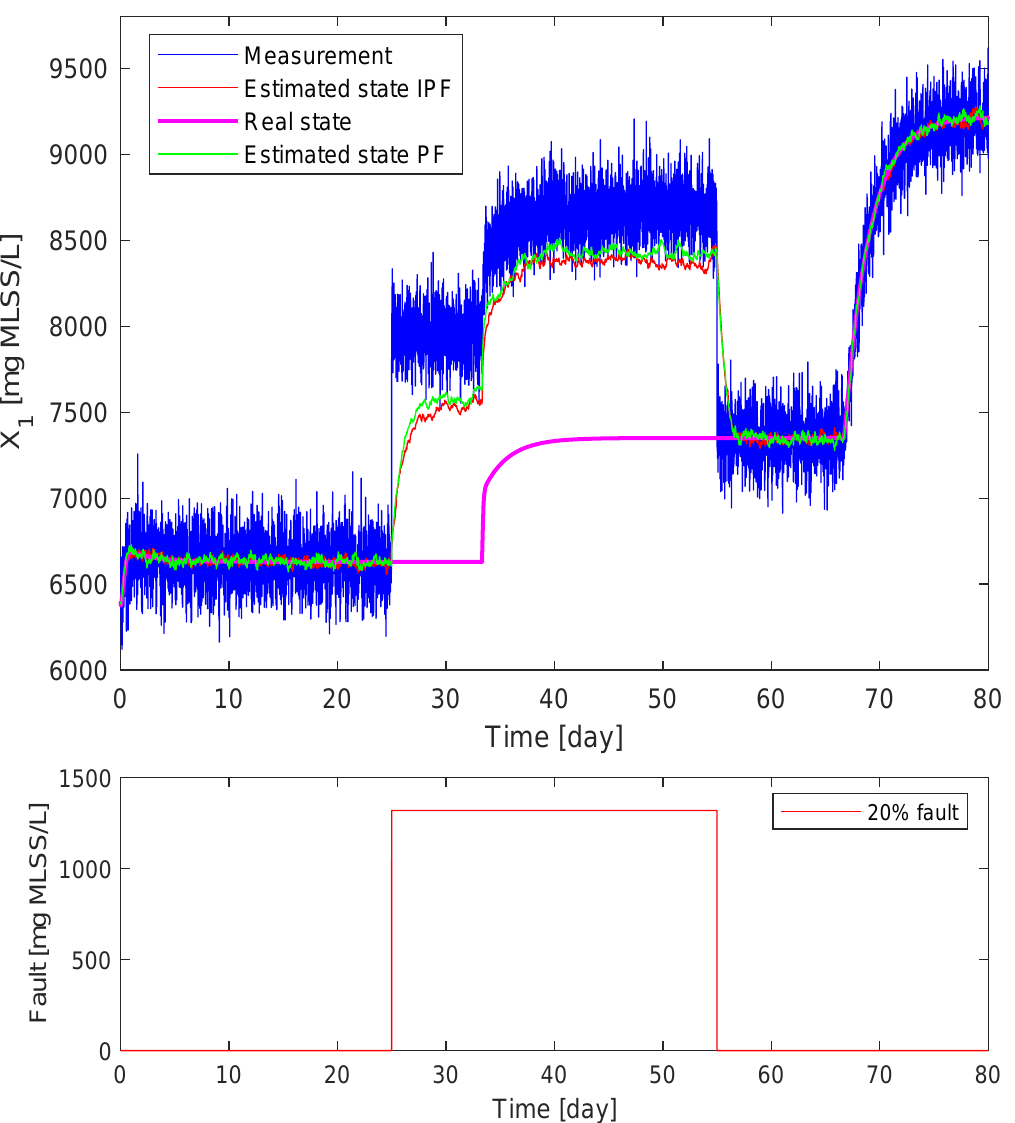
Figure 13. Real, measured, and estimated values of the state variable X 1 by the 20% fault. The value of the 20% fault is 1320 mg MLSS/L. T =